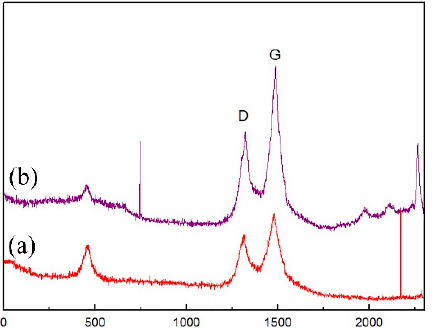
Figure 4. Raman spectra of origin GNPs ( a ) and Al-GNP S ( b ). The optical micrograph and grain size distribution of 2024 matrix alloy, 0.5 wt.% The optical micrograph and grain size distribution of 2024 matrix alloy, 0.5